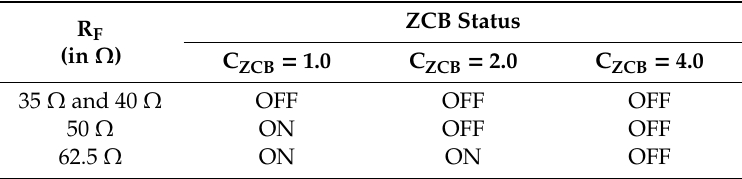
Table 3. Summary of ZCB’s status in three experiments.